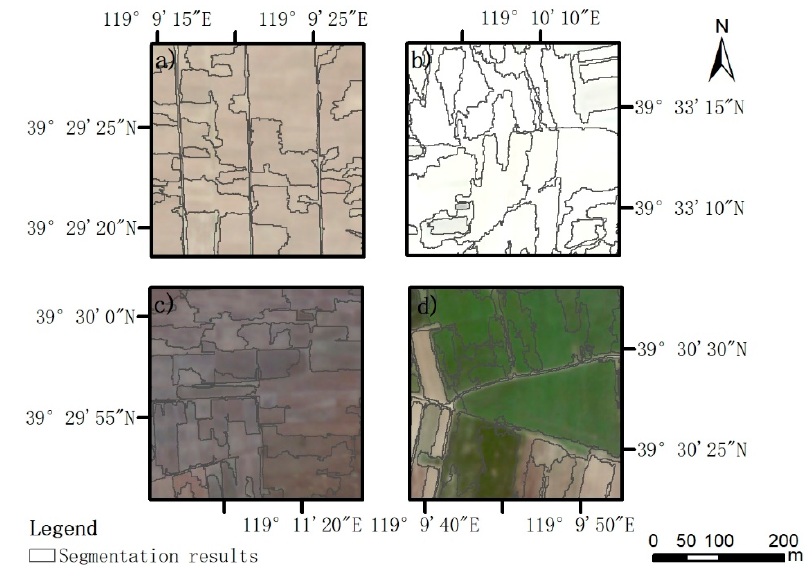
Figure 9. Illustration of intraclass variation of the crop land in the study area. Four patches of crop land with different appearance are shown in ( a ), ( b ), ( c ), and ( d ).